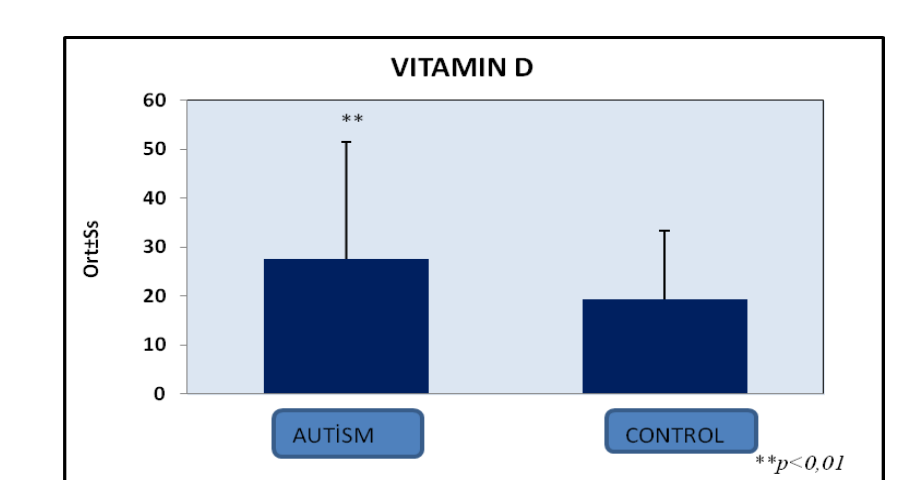
Figure 7. Distribution of Vitamin D Measurements by Groups